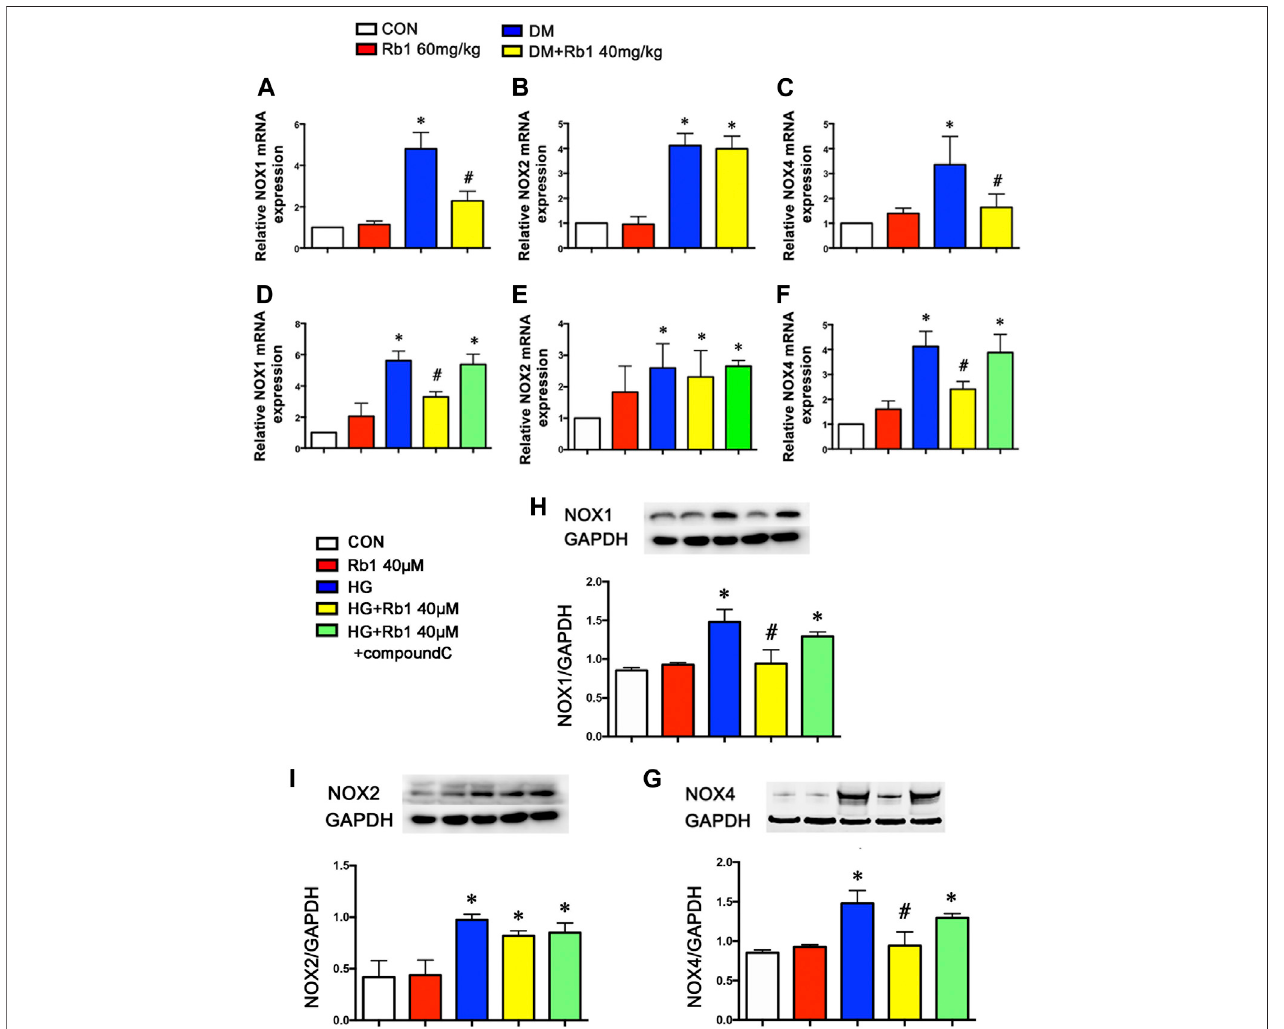
FIGURE7| NOXisoformsinvolvedintheeffectsofRb1onDM-inducedoxidativestress.Quantitativeanalysisof (A) NOX1 (B) NOX2and (C) NOX4mRNAexpressioninthe aorta. Quantitativeanalysis of (D) NOX1 (E) NOX2 and (F) NOX4mRNAexpression in VSMCs. RepresentativeWestern blotbandsand semiquantitativeanalysisof (H) NOX1 (I) NOX2 and (G) NOX4 protein expression in VSMCs. Data are mean ± SEM. n (cid:2) 5 – 6, * p < 0.05 vs. Control; # p < 0.05 DM + Rb1 vs. DM and HG + Rb1 vs. HG.